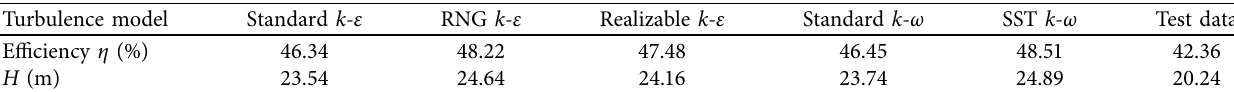
Table 4: Numerical results with different turbulence models at Q